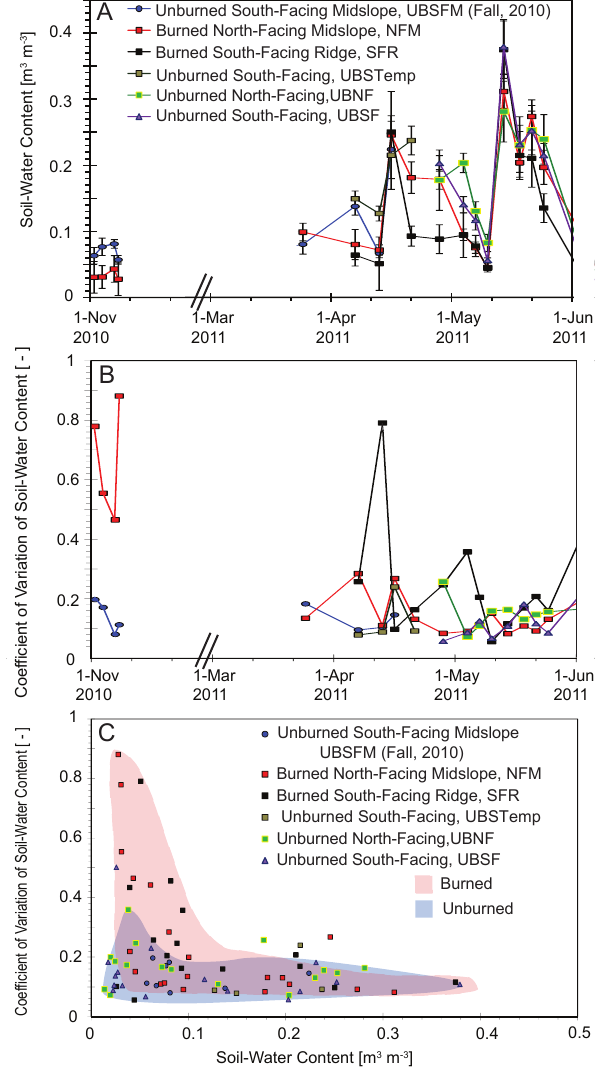
Fig. 6. Thermogravimetric soil-water content from the top 3cm of soil. (A) Time series of soil-water content at selected plots. Error bars represent the standard deviation of four replicate measurements at each plot. (B) Time series of the coefficient of variability of soil- water content for the four replicate samples at each sampling